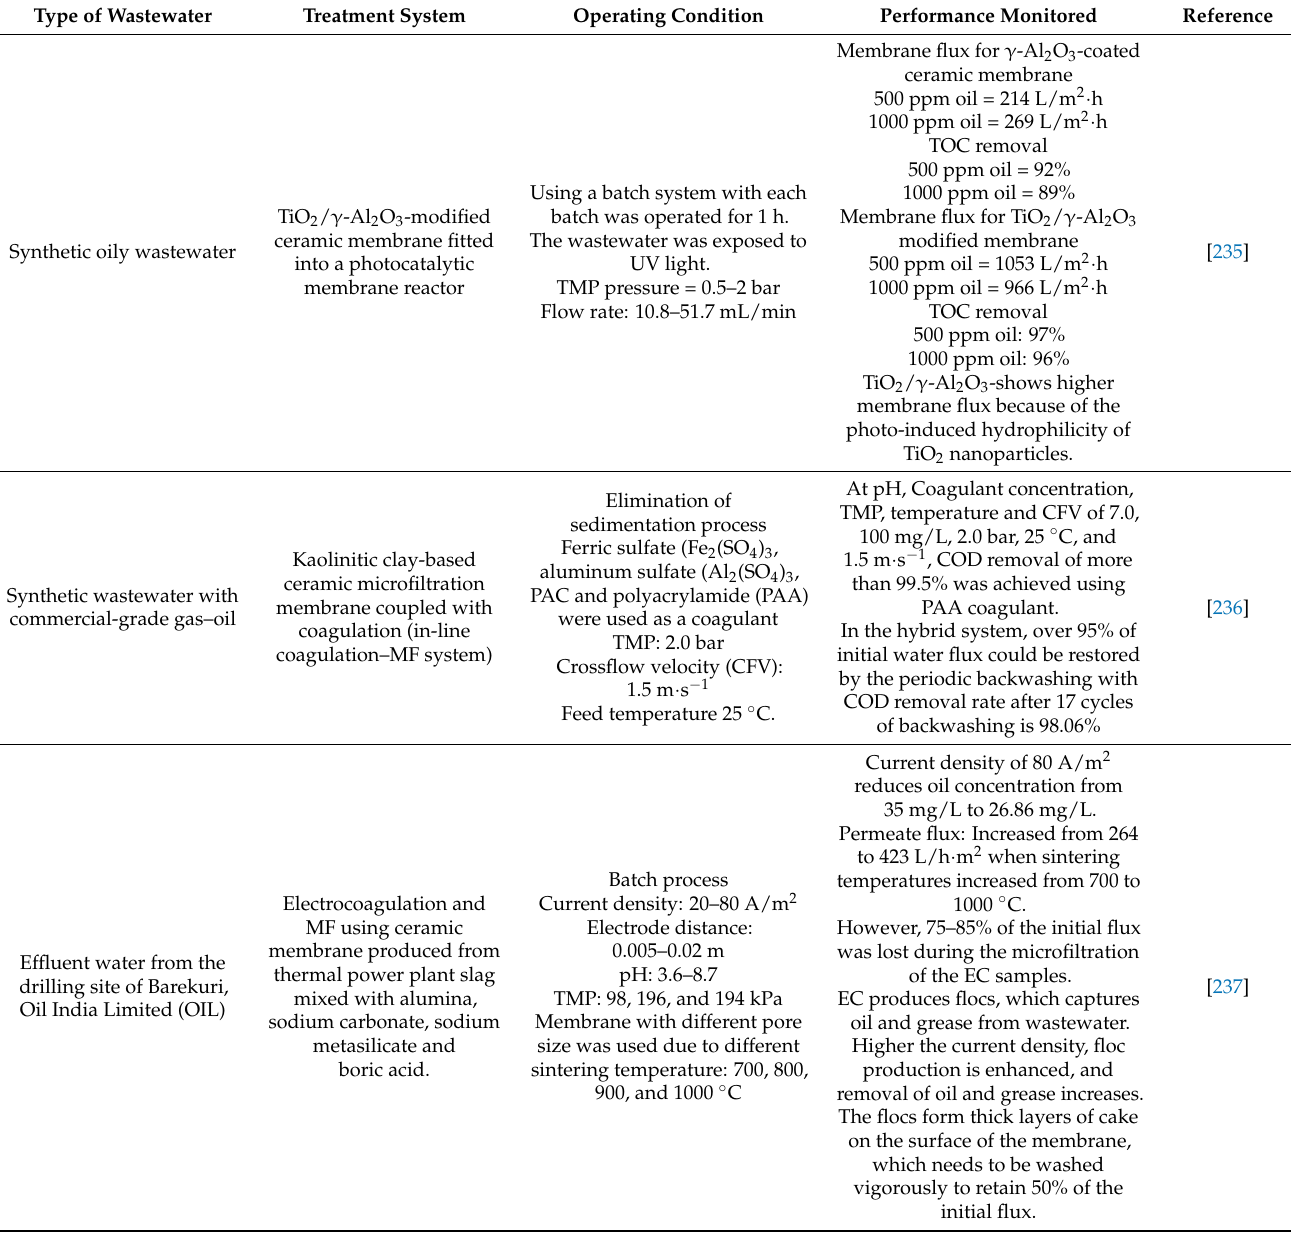
Table 10. Research on integrated oily wastewater cleaning systems using ceramic membrane from 2018 onwards up to